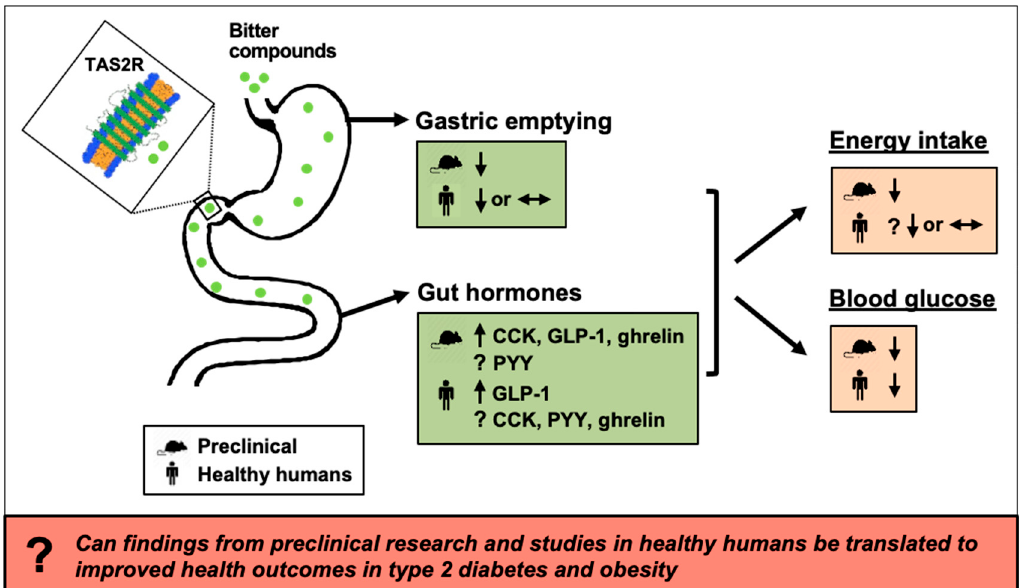
Figure 2. Schematic summarising current knowledge of effects of bitter substances on the secretion of gut hormones, including cholecystokinin (CCK), glucagon-like peptide-1 (GLP-1), peptide YY (PYY) and ghrelin, gastric emptying, energy intake and blood glucose, based on the outcomes of both preclinical studies (cell and animal models) and studies in healthy humans. TAS2R, bitter taste receptor.